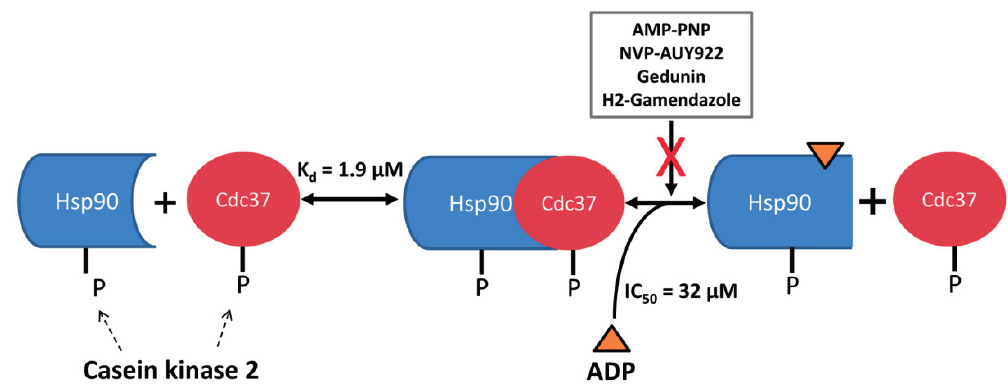
Figure 7. Graphical illustration of the major findings of this